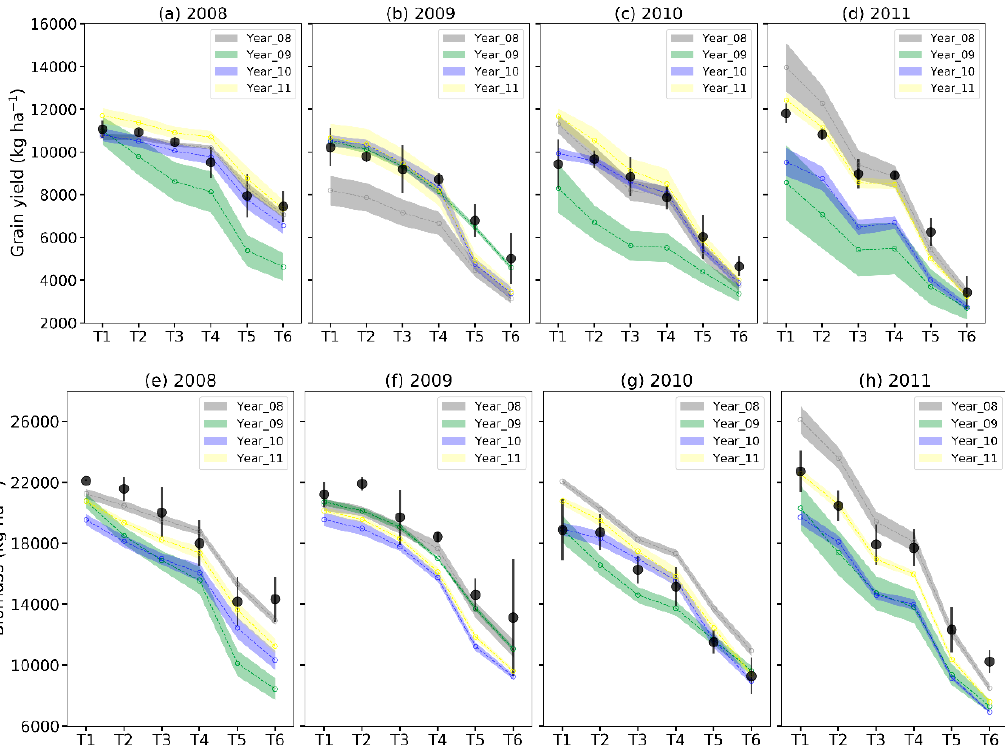
Figure 4. Experimental and simulated grain yield ( a – d ) and biomass ( e – h ) for Year_08, Year_09, Year_10, and Year_11 based on the Calibration-by-Year method (Table 3). The vertical bars and shaded areas are ± 1 Standard Deviation (SD) around the mean for experimental and simulation data, respectively. The SD values was calculated based on the replicates for measured data and on the selected Φ cases for simulated data.